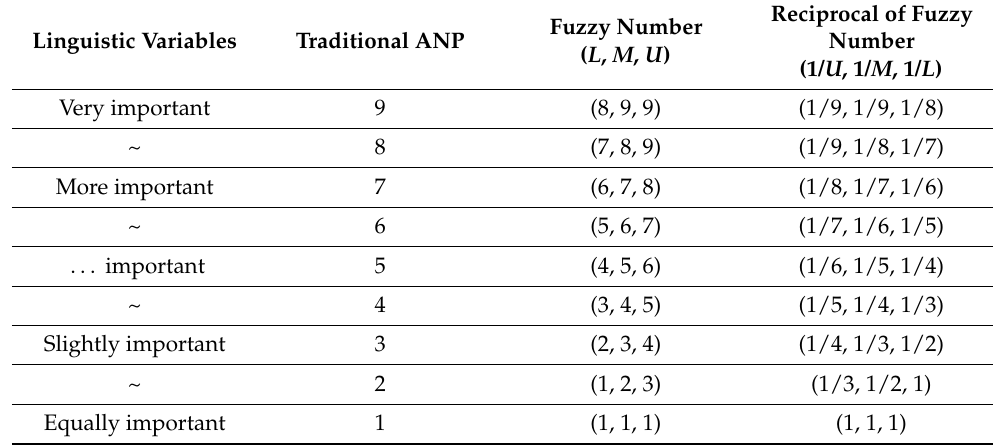
Reciprocal of Fuzzy Fuzzy Number ( L , M , U )